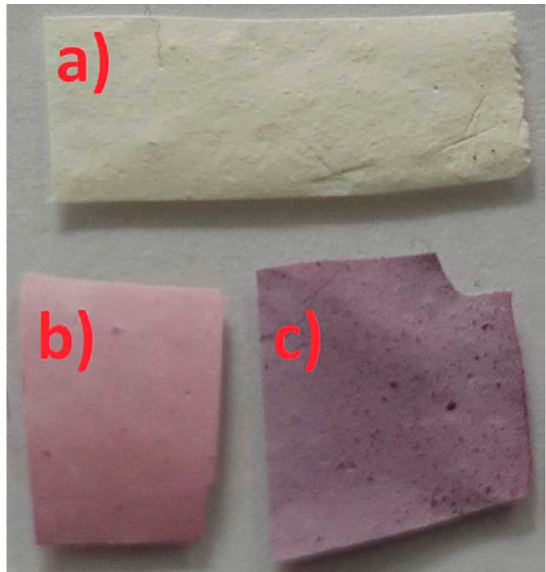
Figure 6. Photograph of differently treated electrospun nanofiber mats: ( a ) pure PAN-TiO 2 ; ( b ) PAN after dip-coating in anthocyanin dye solution and drying; ( c ) PAN-TiO 2 after dyeing, showing a bathochromic shift. From [158], copyright (2022), originally published under a CC-BY-SA license.